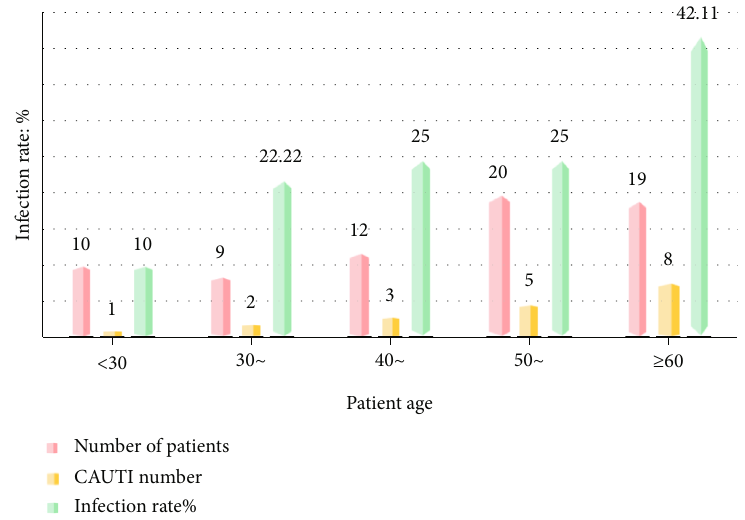
Figure 1: The in fl uence of patient age distribution on CAUTI.